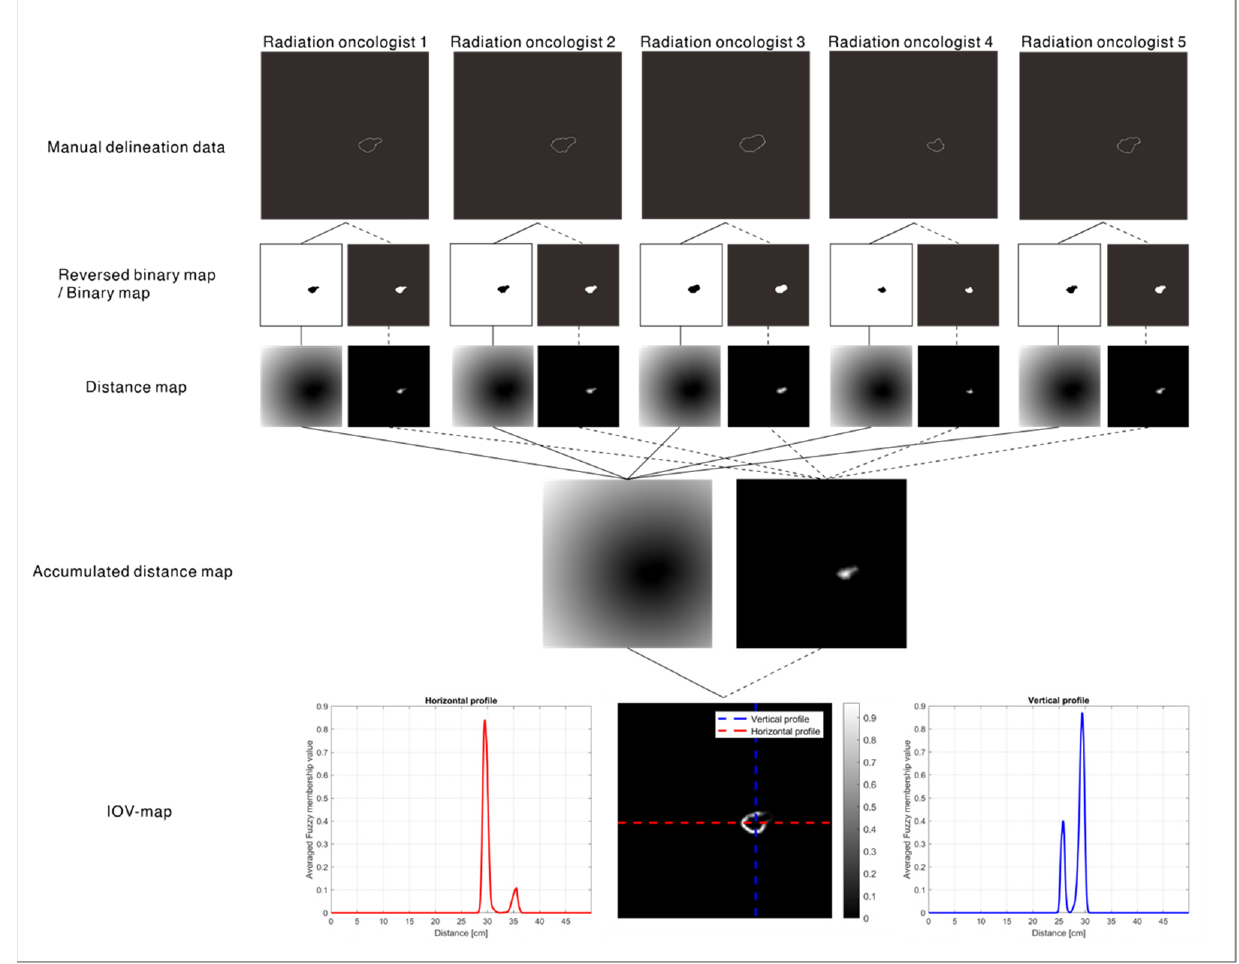
Figure 2. Procedures for creating an interobserver variability (IOV) map from five manual contours and the horizontal and vertical profiles of the IOV map.